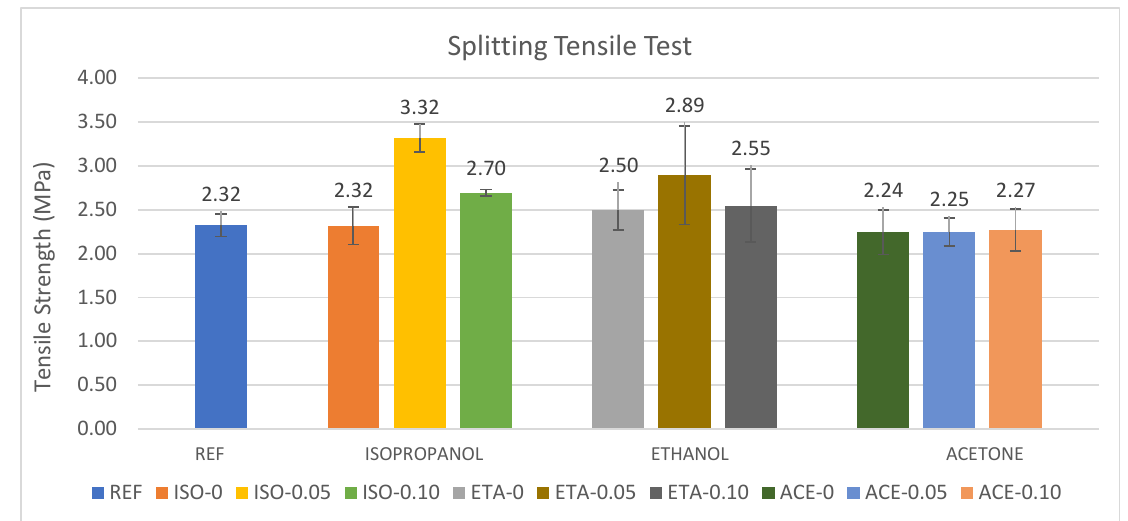
Figure 8. Results of splitting tensile strength tests.